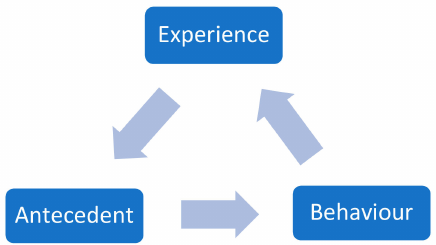
Figure 2. Circular theorizations for behavioural